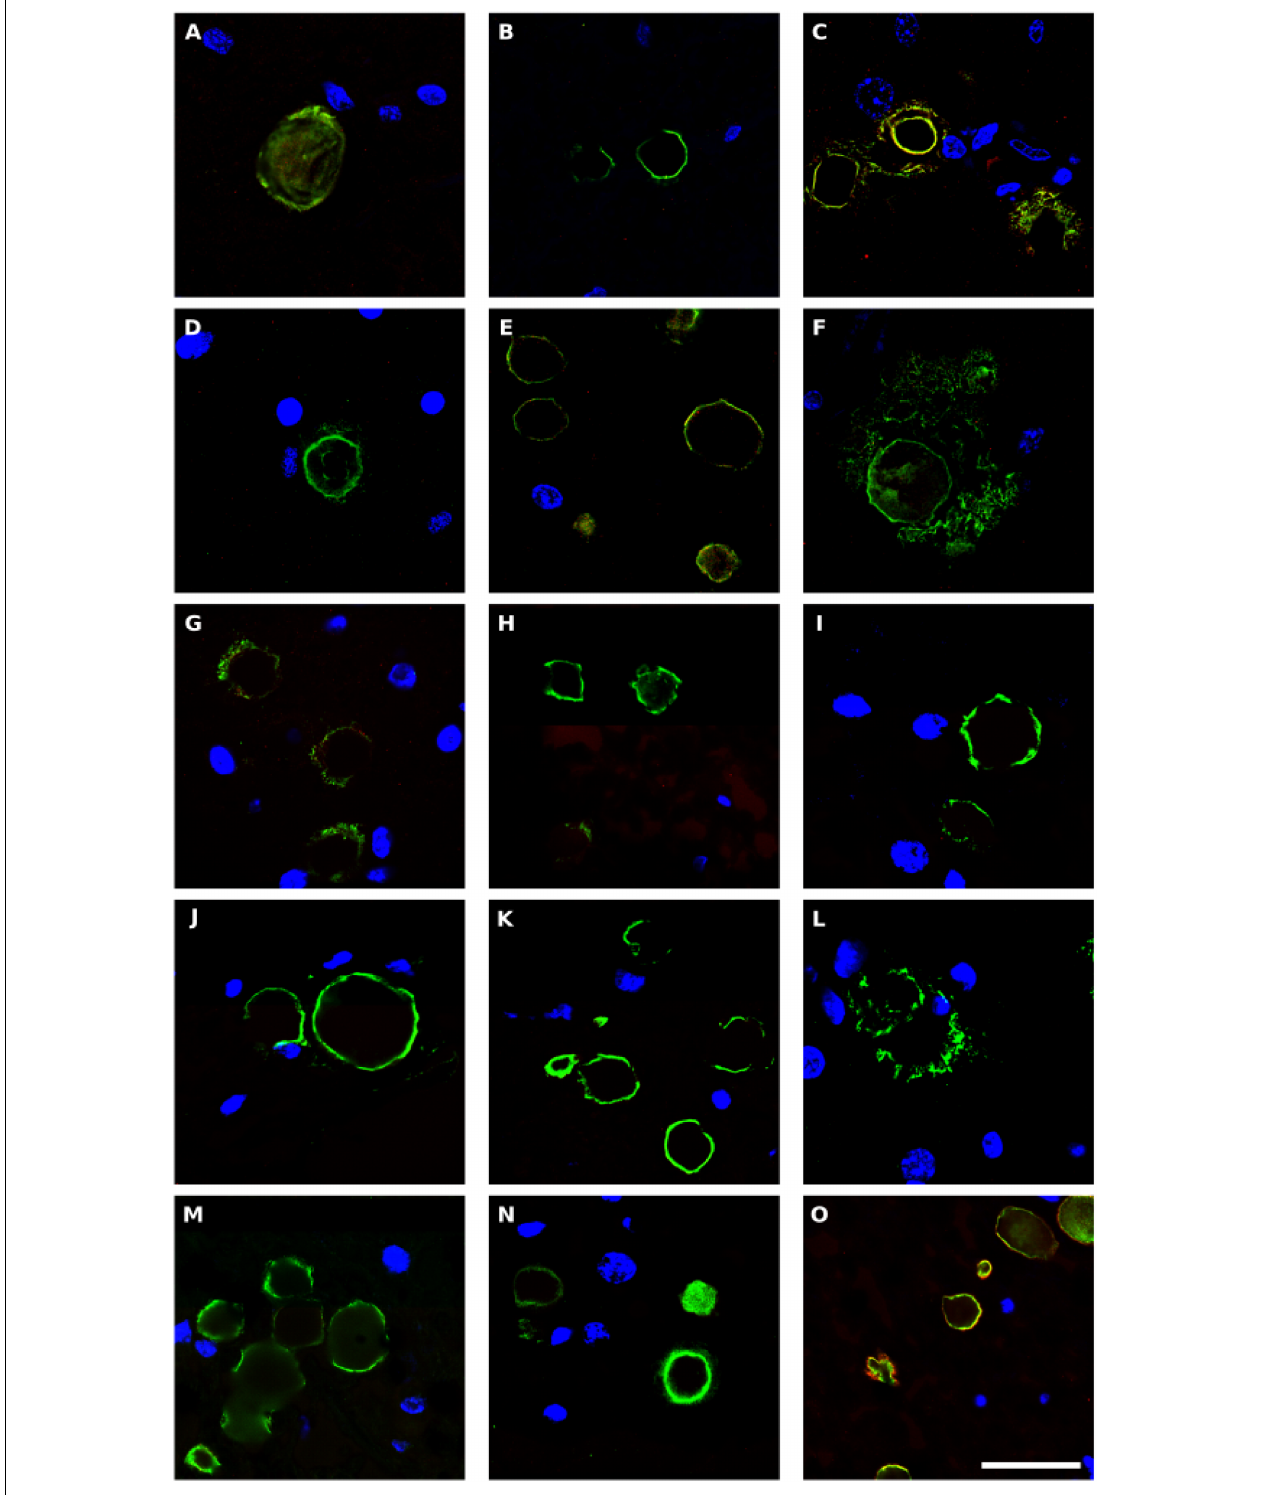
FIGURE 8 | Bacterial proteins in corpora amylacea from ALS patients. Double immunostaining and confocal microscopy were carried out as indicated in section Materials and Methods. CNS sections were immunostained with a mouse monoclonal anti-peptidoglycan antibody (green) (1:20 dilution) and a rabbit polyclonal anti- C. albicans antibody (red) (1:500 dilution). DAPI staining of nuclei appears in blue. Scale bar: 25 µ m. (A,B) ALS2; (C) ALS3; (D,E) , ALS4; (F) ALS5; (G,H) ALS7; (I,J) ALS8; (K) ALS9; (L–N) ALS10; and (O) ALS11. (A,D,F,L) MC section; (G,I,K,M) MD section; and (B,C,E,H,J,N,O) SC section.